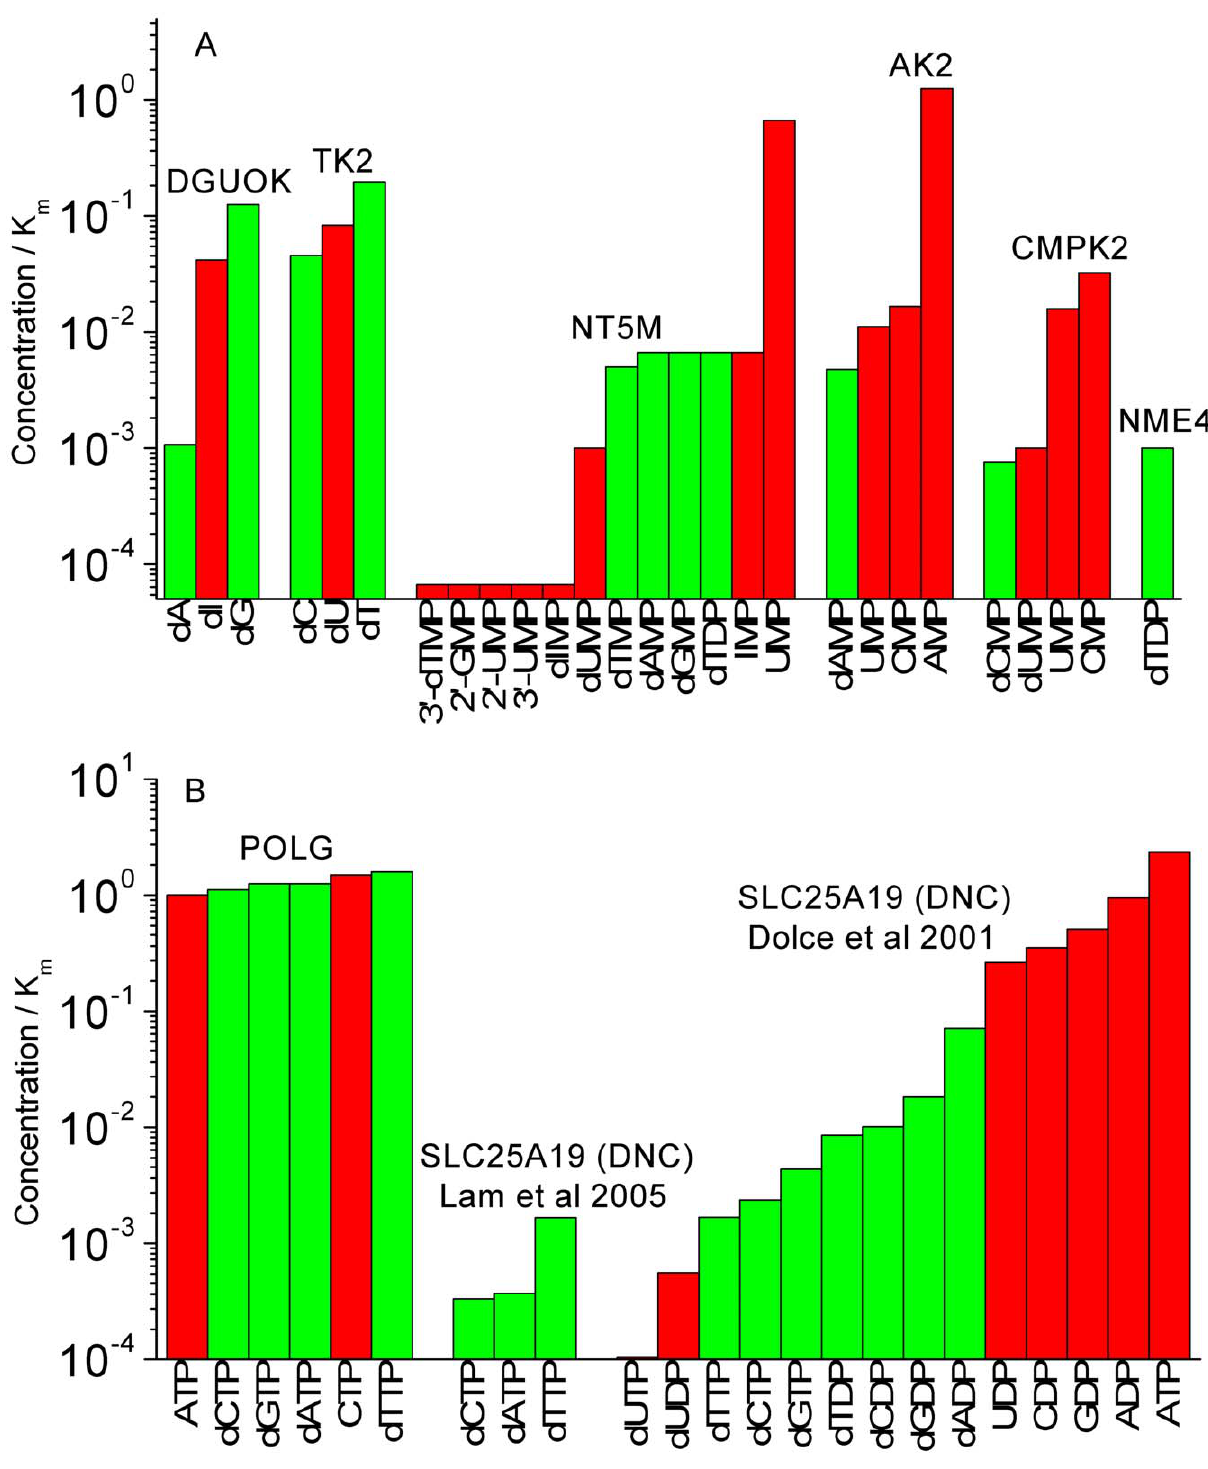
Figure 4. Concentration/K m values in ‘quiescent cells’ for mitochondrial enzymes. Concentration/K m values at lower mitochondrial concentrations (‘quiescent cells’) of the deoxyribonucleotide substrates (1 m M) for ( A ) mitochondrial salvage enzymes and ( B ) POLG and